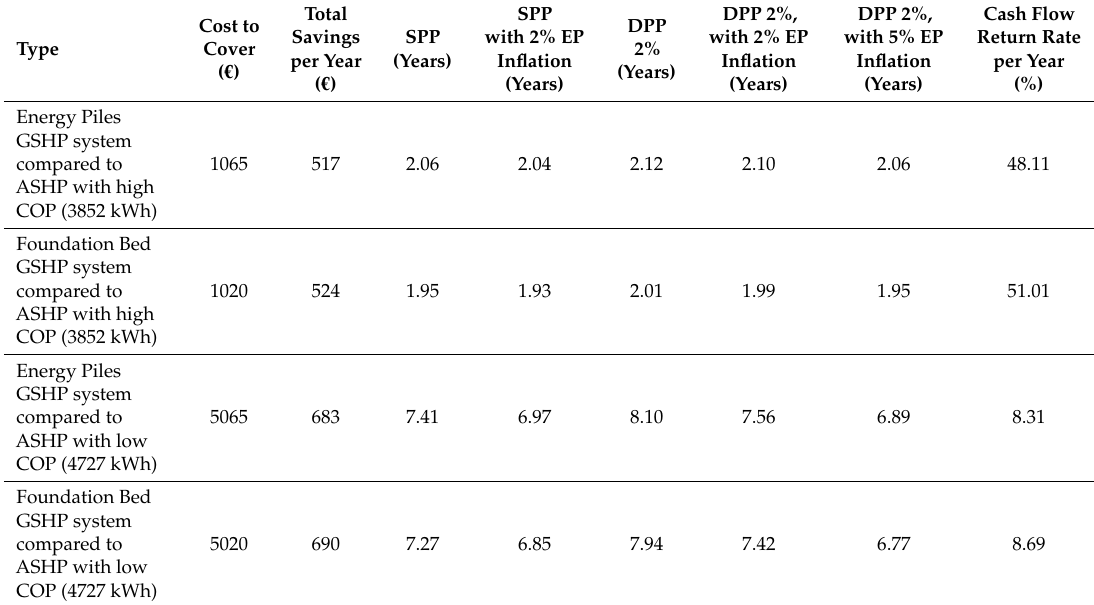
Table 8. SPP-DPP results for the two GSHP systems compared to high and low e ffi cient ASHP